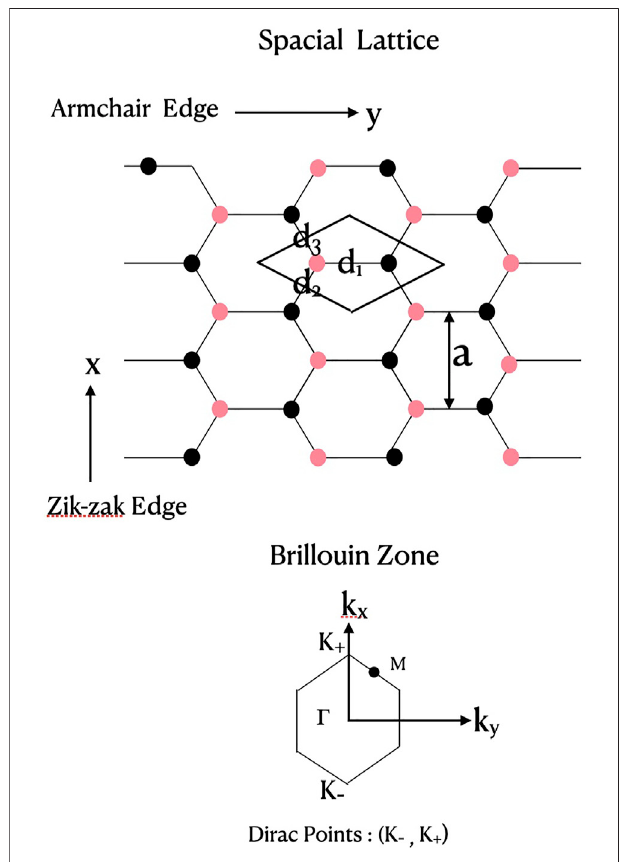
FIGURE 1 | Lattice structure of a graphene monolayer. The upper part shows a 2D hexagonal carbon lattice with two (red, black) interpenetrating triangular Bravais sub-lattices. The unit cell (rhombus) has two atoms per cell (red, black). The nearest neighbour distances from one atom (red) are ( d 1 , d 2 , d 3 ); a CC iscarbon-carbonbondlength, a (cid:1) 0.246 nm = 4.649 [a.u.]. Note the “ armchair ” structure along the horizontal axis and the “ zik-zak ” structure along the vertical axis. The lower part of the fi gure shows the fi rst Brillouin zone with symmetry points ( Γ , M ) and the Dirac points ( K − , K +